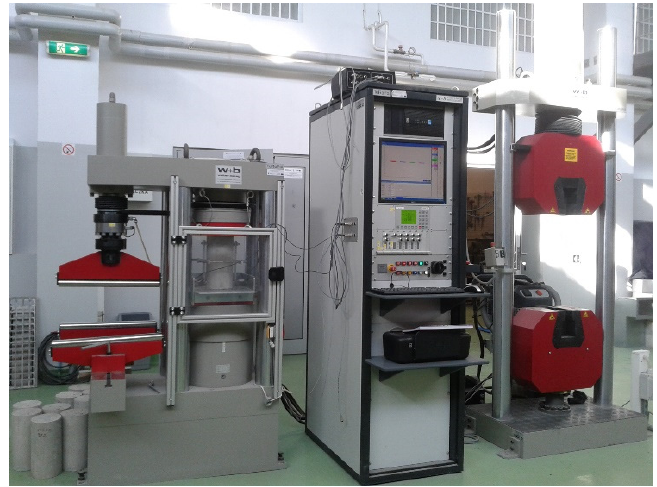
Figure 1. The test stand for testing the static modulus of elasticity.